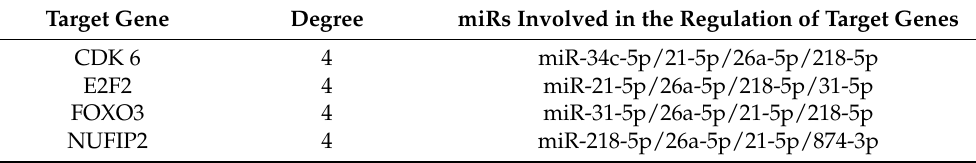
Figure 2. The scheme of ncRNAs with potential for regenerative dentistry. ncRNAs labeled in green promote while ncRNAs labeled in red inhibit osteogenic/odontogenic differentiation of stem cells. Table 4. Bioinformatic analysis (miRnet) of miRs involved in the regulation of osteogenic differentia- tion of human periodontal ligament stem cells and osteogenesis in vivo showing the top four target genes with the highest degree in the miR-mRNA regulatory